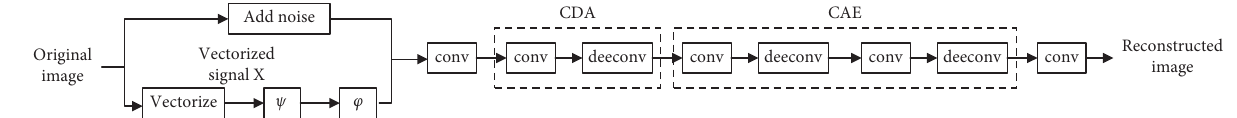
Figure 3: The structure diagram of strategies. Table 1: Reconstruction accuracy comparison results of D-AMP, ReconNet, and SCDA algorithms (the measurement rate is